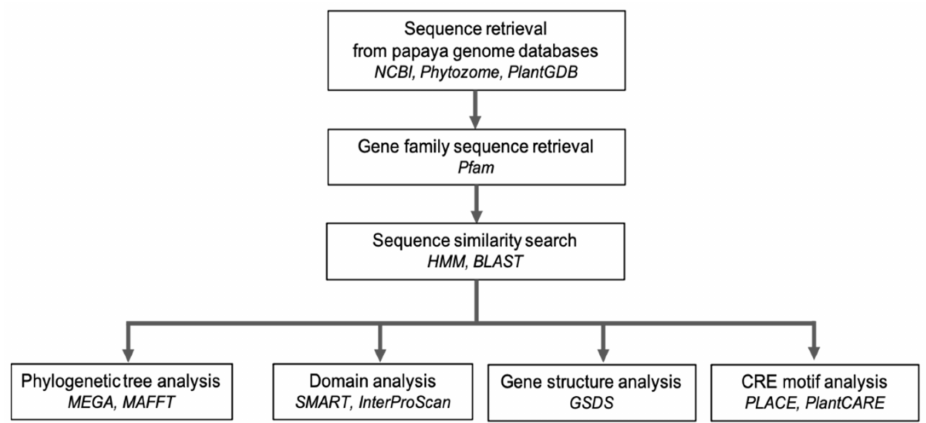
Figure 3. Workflow for comparative genomics analysis of the papaya gene